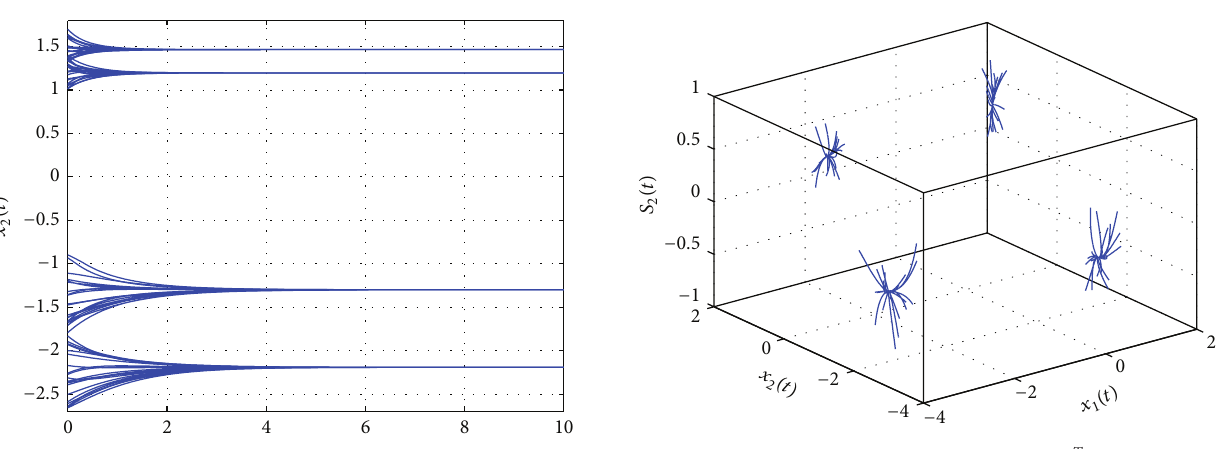
Figure 6: Phase plot of state variable (𝑥 1 , 𝑥 2 , 𝑆 2 ) 𝑇 in Example 1.